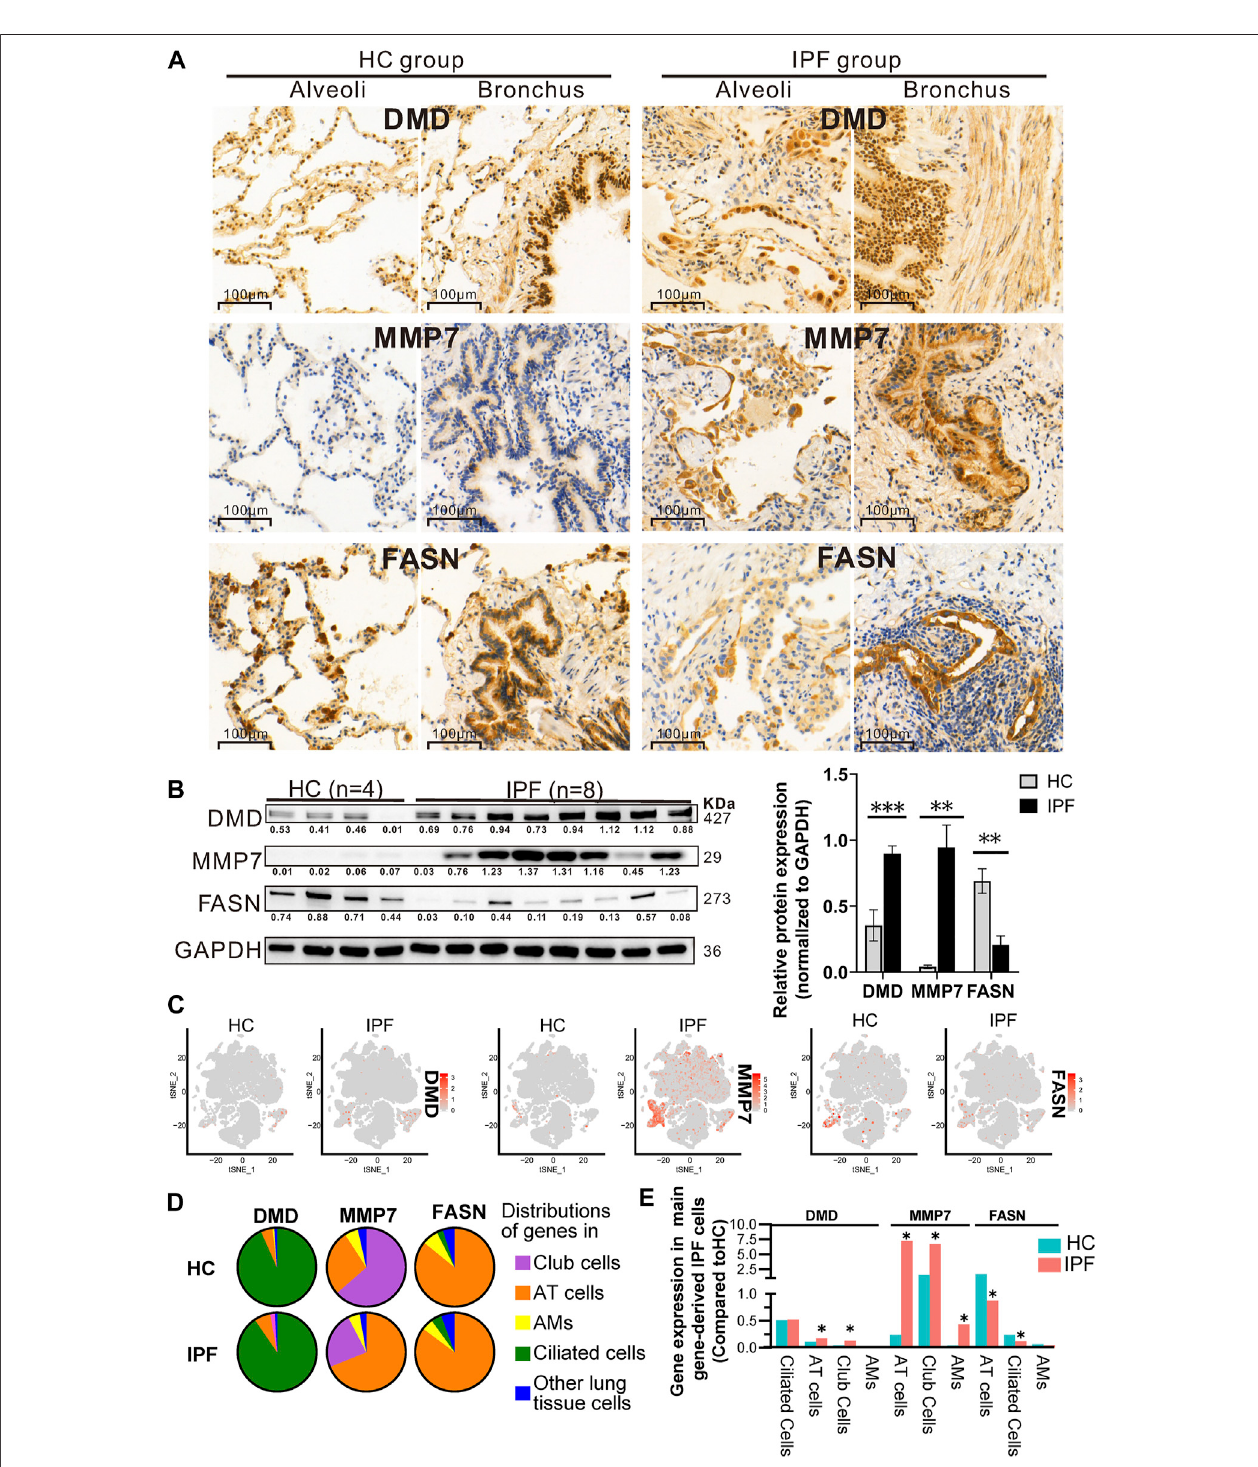
FIGURE5| ProteinexpressionofandcelloriginsofDMD,MMP7,andFASNbasedonmultipleanalysesofIHC (A) ,WB (B) ,andscRNA-Seq (C – E) . (A) Theprotein distribution of DMD, MMP7, and FASN in lung tissue of IPF and HC via IHC experience. Each gene displays protein expression in the two fi elds of alveoli and bronchi. In addition, brown indicates that the gene has protein expression, and the darker the color, the greater the expression. (B) The protein expression of DMD, MMP7, and FASN in lung tissue of IPF and HC by WB experience, showing WB exposure bands (on the left) and bar charts of statistical analysis (on the right). Lung tissue derived from 8 IPF (4 from SLB and 4 from transplantation) and 4 HC. And GAPDH served as the internal reference. Error bars indicate mean ± SEM, and their three results were consistent with that of mRNA-Seq according to a two-tailed Student ’ s t-test. * p < 0.05, ** p < 0.01, *** p < 0.001. (C – E) tSNE plots (C) displaying